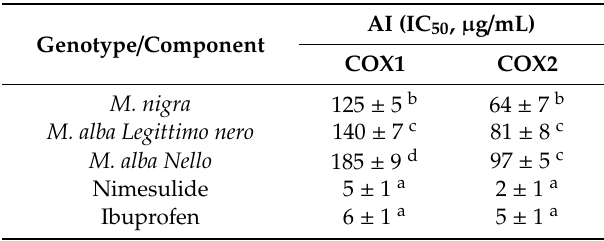
Table 4. Anti-inflammatory activity (AI) of mulberry genotypes measured as COX-1 and COX-2 inhibitory activity expressed as IC 50 , µ g / mL extract. Values represent the results of three determinations ± SD; means with di ff erent letters in the same column are significantly di ff erent from each other ( p < 0.05) according to the multicomponent Duncan’s